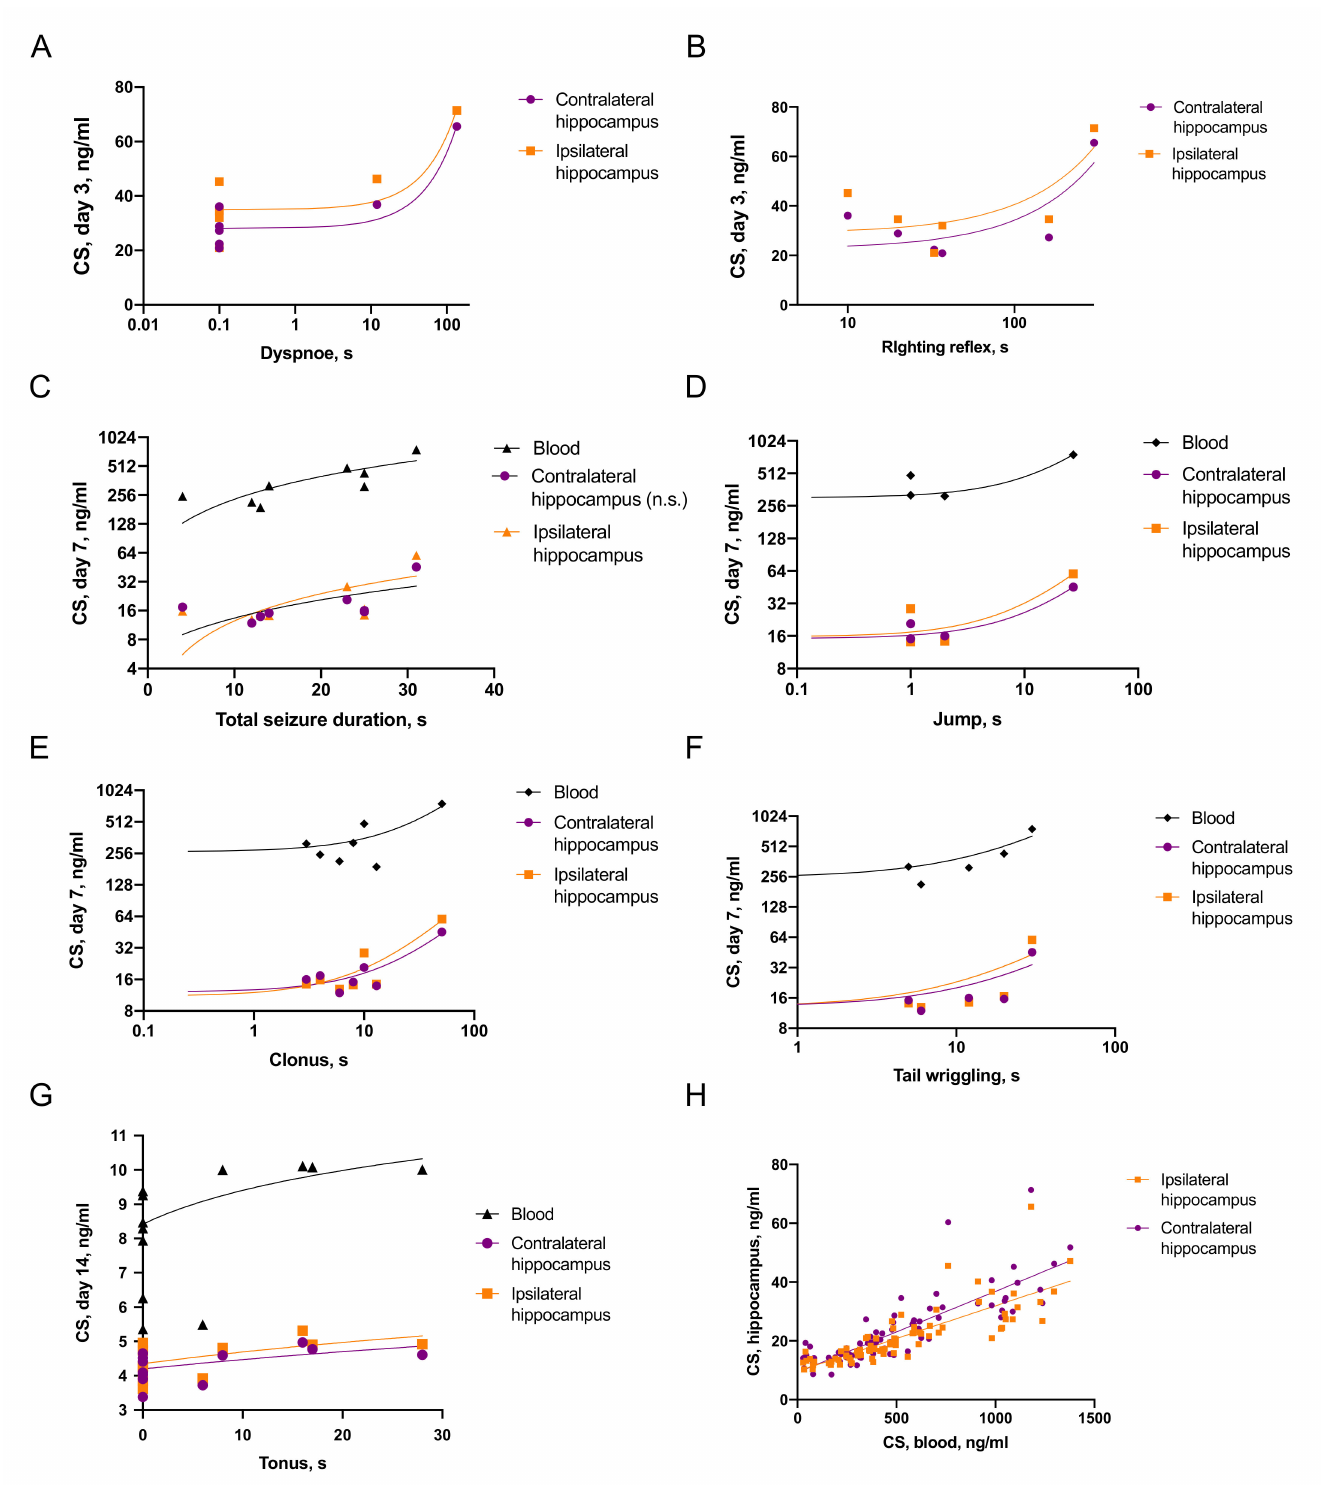
Figure 3. Associations between immediate seizures and CS elevation. ( A , B )—Duration of dyspnoe and recovery of righting reflex correlates with CS level on day 3 (n = 7). ( C – F )—Duration of immediate seizure elements correlates with CS level in blood and the hippocampus on day 7 after TBI (n = 8). ( G )—Duration of tonus correlates with CS level in blood and the hippocampus on day 14 after TBI (n = 13). ( H )—Correlations of CS levels in blood and the hippocampus (n =